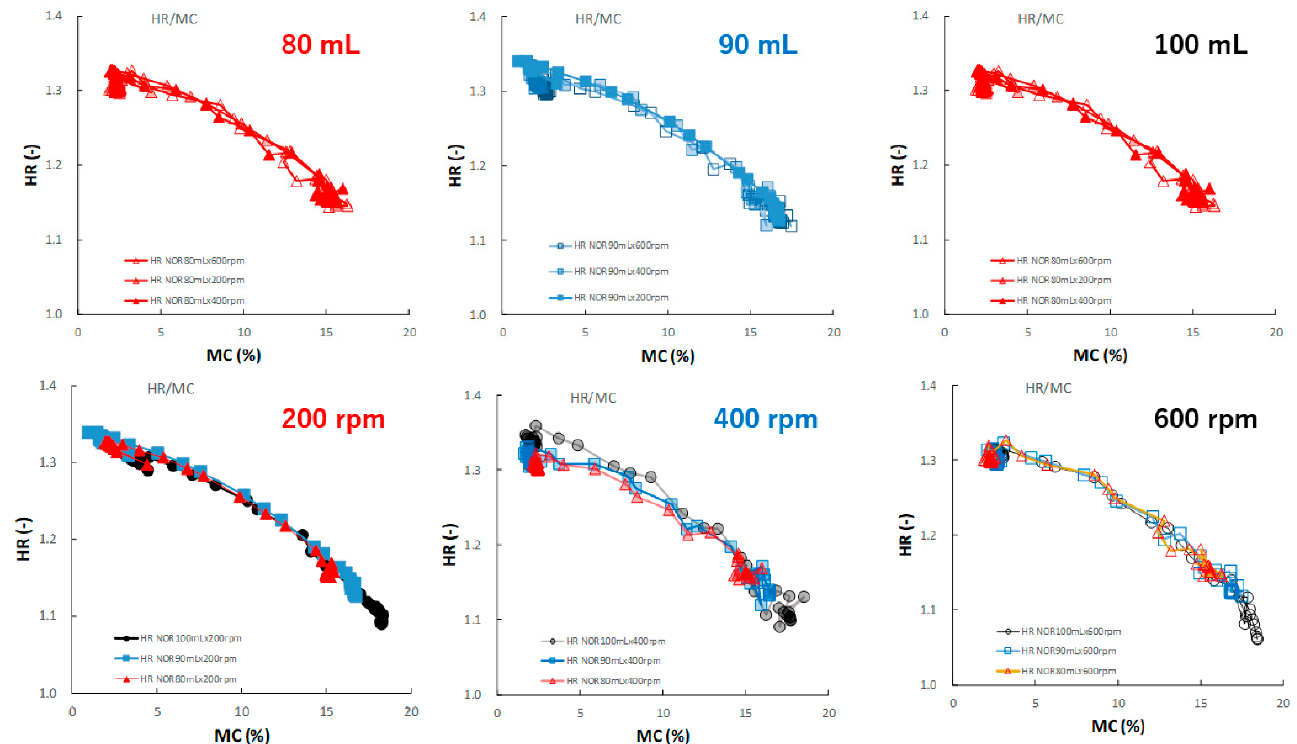
Figure 13. The effect of adding water and increasing stirring speed on the relationship between HR and MC of the HSWG granules. and MC of the HSWG